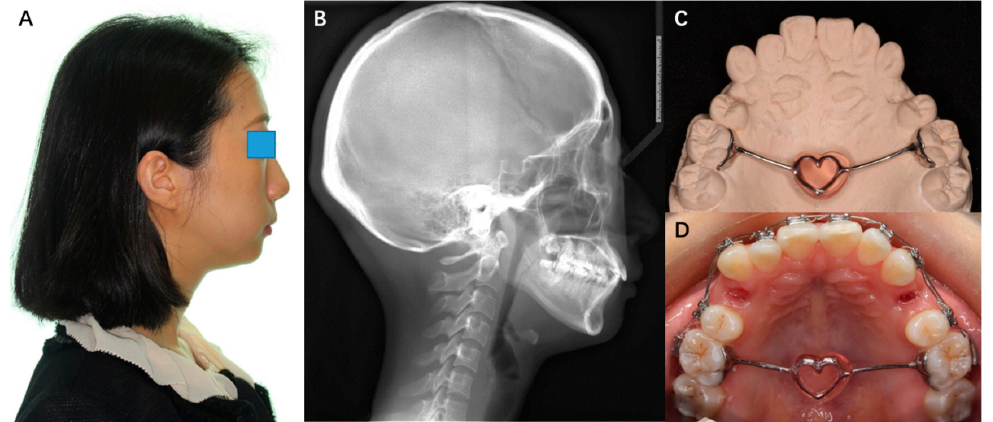
Figure 3. ( A ) The profile of patient before treatment; ( B ) the lateral cephalometric radiograph before treatment; ( C ) 3D TPA on model; ( D ) 3D TPA applied intraorally.